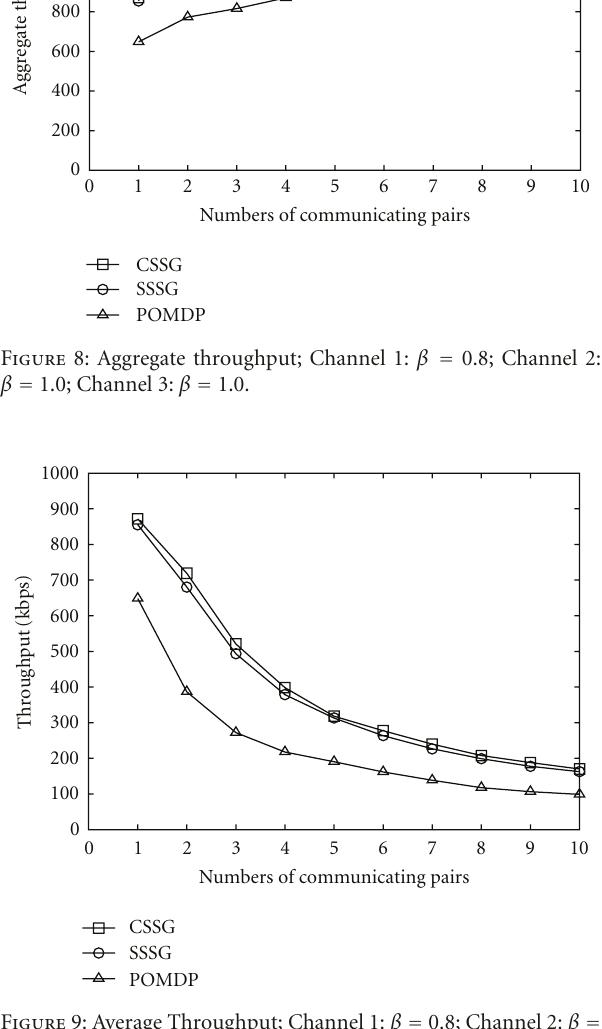
Figure 7: Average Throughput; Channel 1: β = 1.0; Channel 2: β = 1.0; Channel 3: β = 1.0.